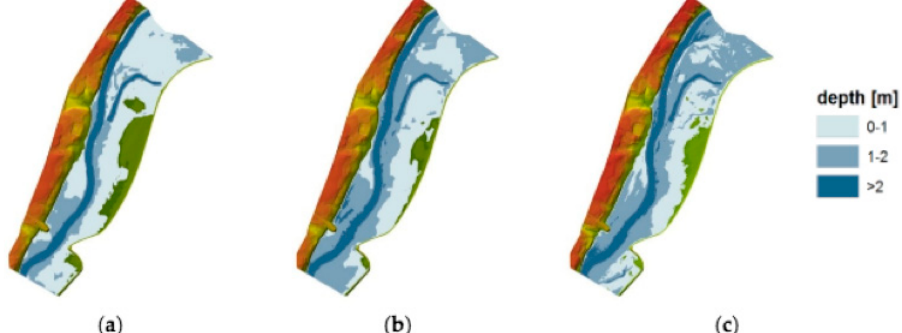
Figure 4. Comparison of flood extent and flood depth obtained from flood model simulation: ( a ) original DEM; ( b ) corrected DEM; ( c ) reference DEM [77].